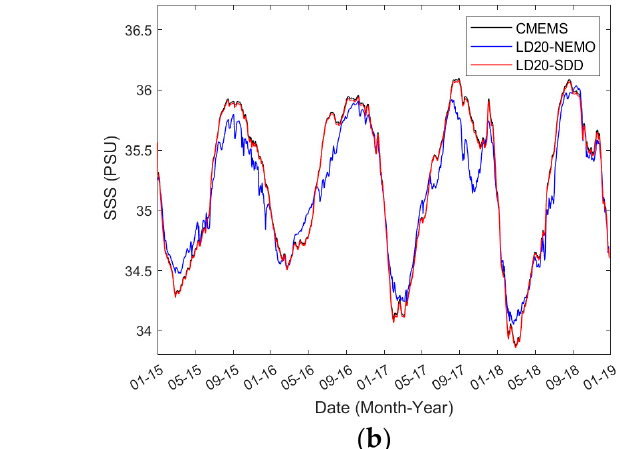
Figure 4. Time series of area averaged surface temperature and surface salinity for different data sets for the period 1 January 2015 to 1 January 2019: ( a ) surface temperature for the numerical mod- els CMEMS, LD20-NEMO and LD20-SDD together with data products based on measurements OS- TIA and GHR-MUR, ( b ) surface salinity for CMEMS, LD20-NEMO and LD20-SDD. The large seasonal variability in temperature and salinity in the Lakshadweep Sea was consistent with observations carried out during the Arabian Sea monsoon experiment (ARMEX), see [34]. In contrast with salinity, the yearly cycle for temperature had two peaks due to the monsoon climate in the area. India receives southwest monsoon winds in summer and northeast monsoon winds in winter. The time series of model skill param- eters specified by Equations (6)–(13) are shown in Figure 5.